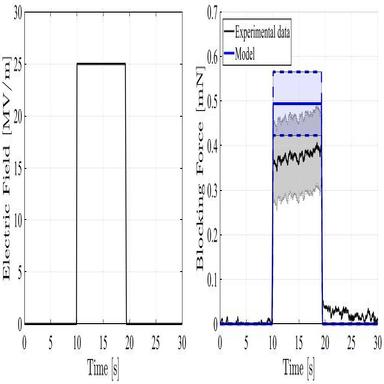
Time transient experimental and model blocking force when a square electric field input is applied to (at least) three soft actuators with transversally aligned nanofibers integrated in PDMS. The blue shaded areas represent the simulation results with the relative permittivity values spanned between 9 and 12, while the gray shaded areas represent the standard deviation on the electromechanical characterization.